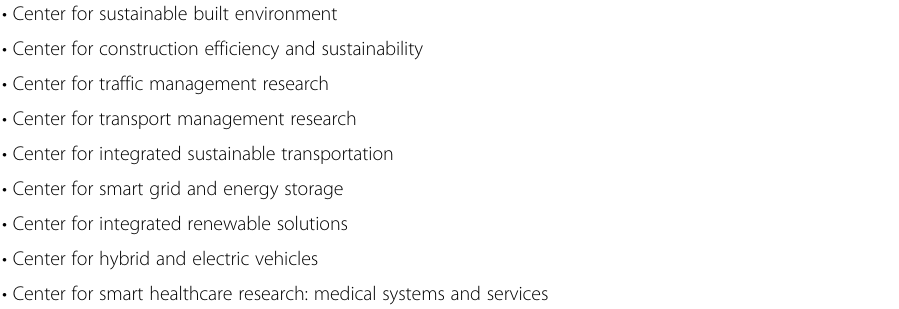
Table 13 Competence centers for sustainability (cid:129) Center for sustainable built environment (cid:129) Center for construction efficiency and